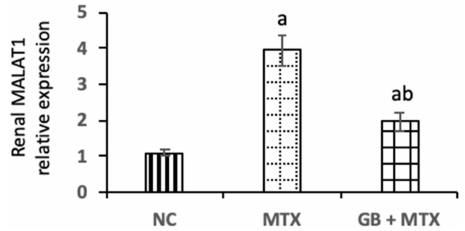
Figure4. E ff ectof20mg / kgmethotrexate(MTX,ip)onlyandwhencombinedwith60mg / kg Ginkgobiloba extract (GB, orally for 10 days) on long non-coding RNA-metastasis-associated lung adenocarcinoma transcript-1 (MALAT1) expressions in renal tissue in all studied groups. a p < 0.05 versus NC group. b p < 0.05 versus MTX